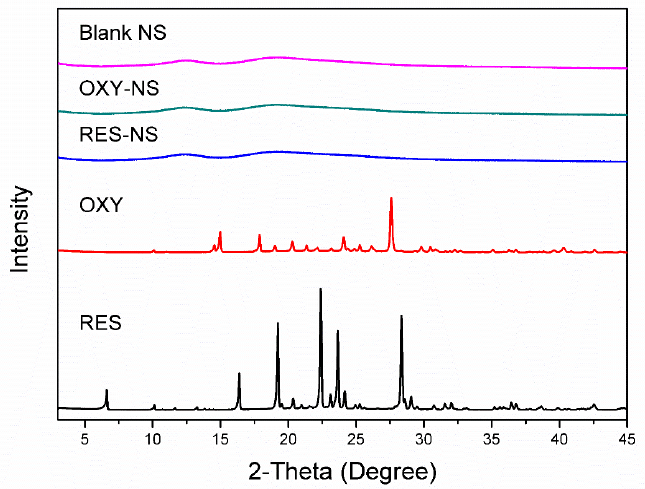
Figure 6. PXRD pattern of RES, OXY, RES-NS, OXY-NS and blank NS.